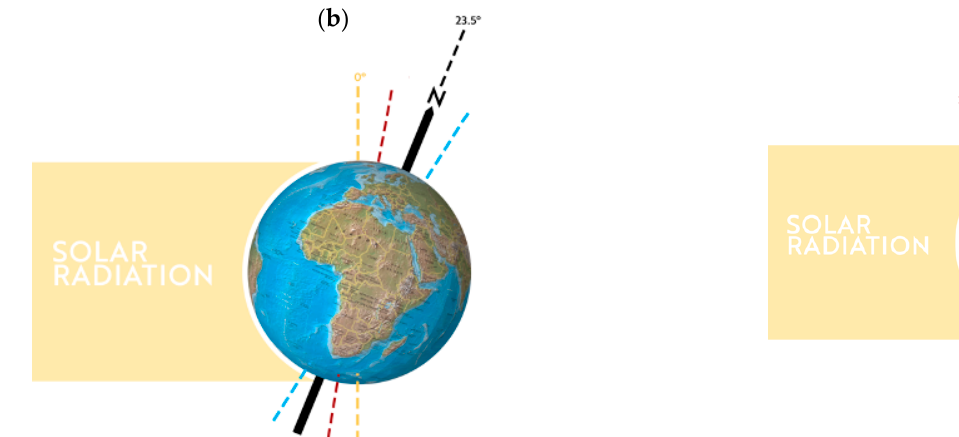
Figure 4. ( a ) Eccentricity variation of the Earth’s orbit around the Sun with a period of 100 K years; ( b ) Earth’s axis inclination cycle, from 21°55 ′ to 24°20 ′ , with a period of 41 K years; ( c ) precession cycle, i.e., double-cone Earth’s axis motion, with a period of 23 K years.